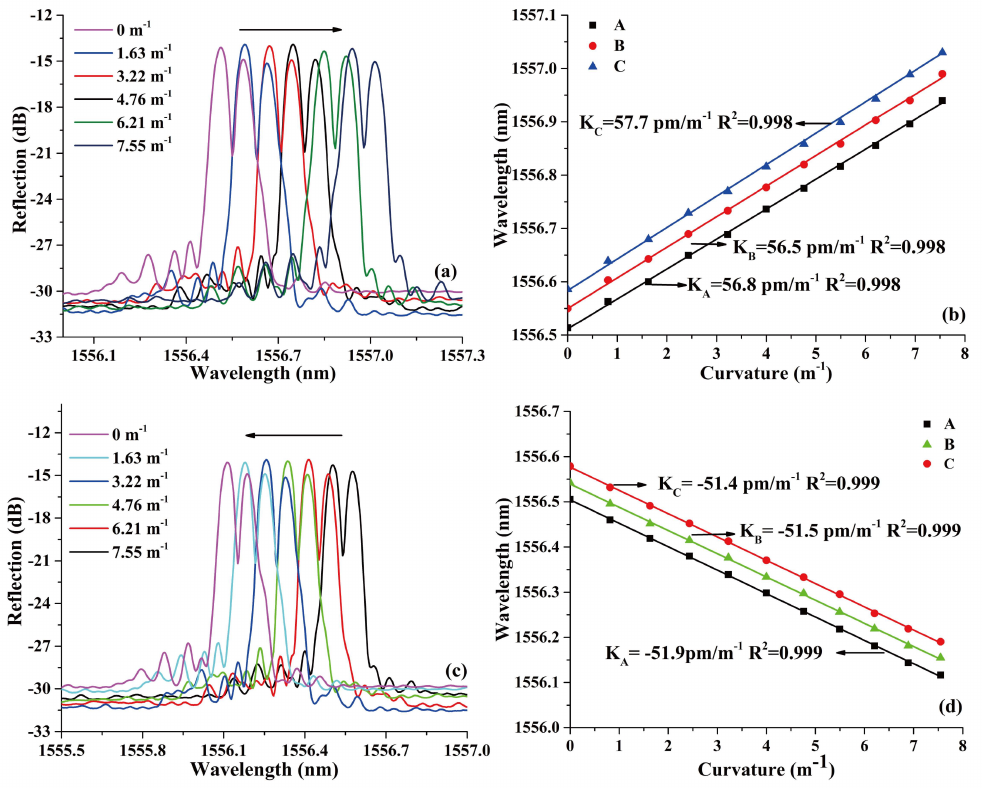
Figure 5. Spectral responses of the PS-ECFBG under different curvatures at ( a ) 0 ◦ and ( c ) 180 ◦ , and ( b , d ) the corresponding linear fit of peaks A, B, and C.